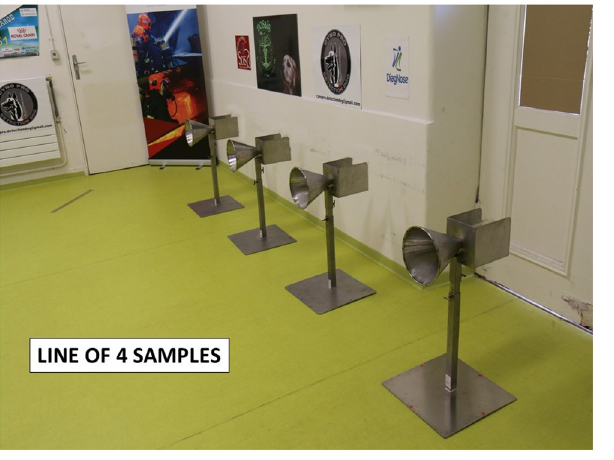
Fig 6. 4-olfactory cone